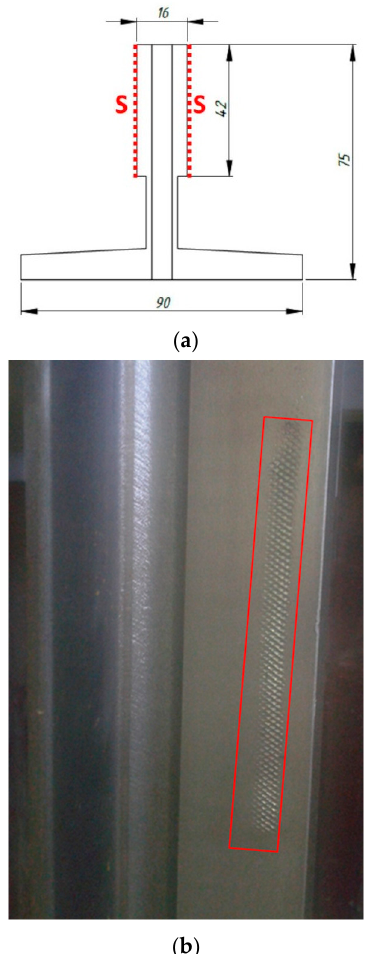
Figure 2. Rail T90 / A: ( a ) drawing—cross-section, ( b ) view with plastic damage on guide rail Figure 2. Rail T90/A: ( a ) drawing—cross-section, ( b ) view with plastic damage on guide rail working working surface.